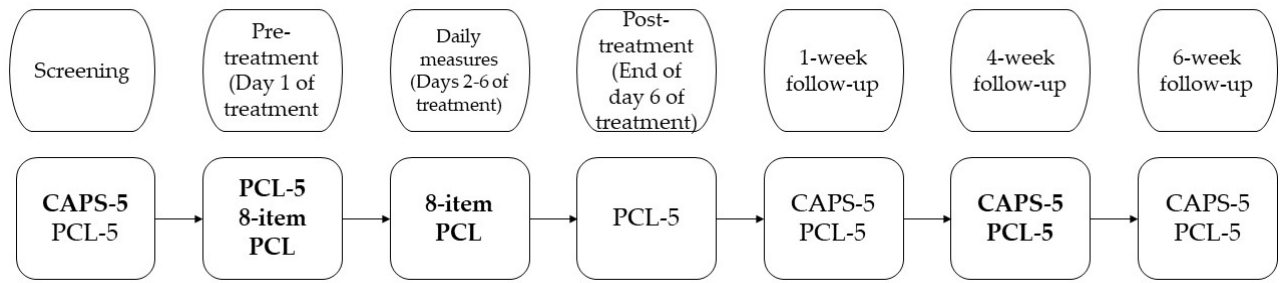
Figure 1. Measuring moments. The pre-treatment and daily measures were conducted at the start of the day before actual treatment was delivered. Not all measuring moments were used in the current study, the measurements in bold were the ones used.